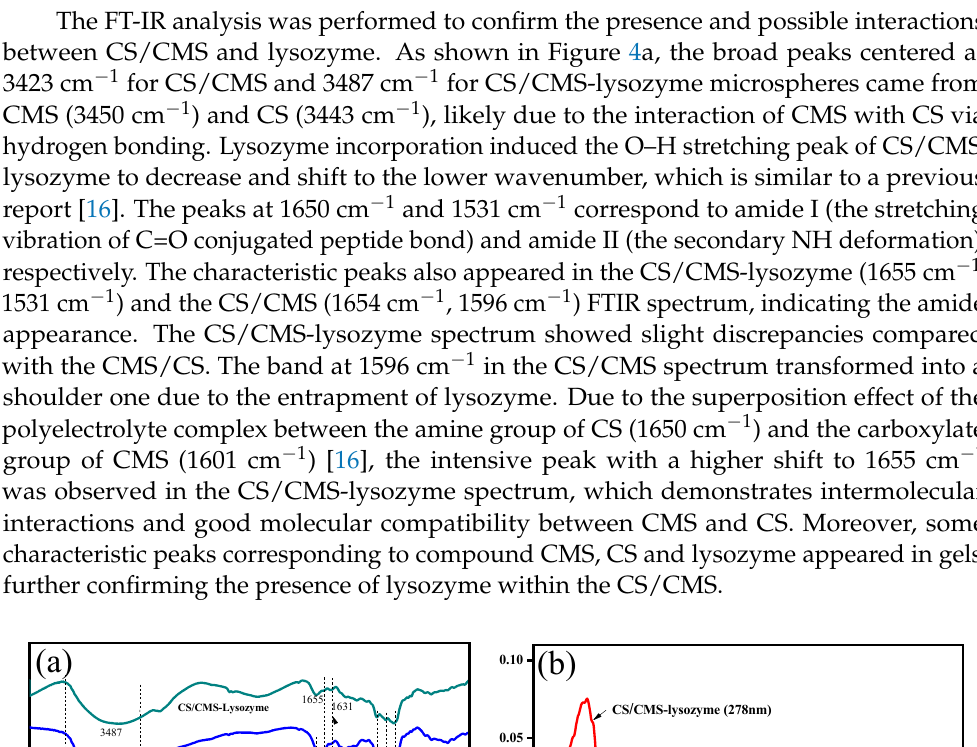
Figure 5. Relative activity of lysozyme released from CS/CMS. Bars represent the corresponding standard deviations ( n = 3). 3.4. In Vitro Release Studies As the intestine is generally considered as the main absorption site, in vitro diges- tion and release of lysozyme from chitosan-based formulations was performed under simulated digestive fluids to investigate their intestinal targeting during the formulation. The pH and ionic strength associated with local conditions in the stomach and small in- testine fluids are quite different from each other. The protective effect of polysaccharide